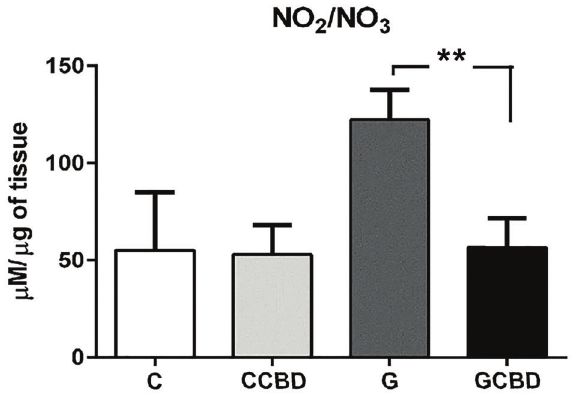
Figure 5. Nitrite/nitrate concentration in intestine tissue homo- genate. Data are reported as means ± SD C: control; CCBD: control + cannabidiol; G: gastroschisis; GCBD: gastrosquisis + cannabidiol. **P o 0.005 (Kruskal